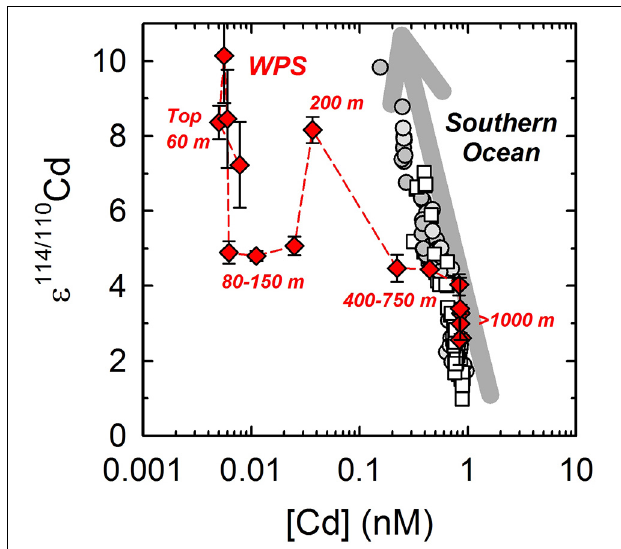
FIGURE 3 | Relationship between Cd concentration and ε 114 / 110 Cd in the water column of the West Philippine Sea (WPS), along with the data from Abouchami et al. (2011, 2014) and Xue et al. (2013). Diamonds in red: data of WPS; Circles in gray: data of Antarctic Circumpolar Current; open squares: data of Weddell